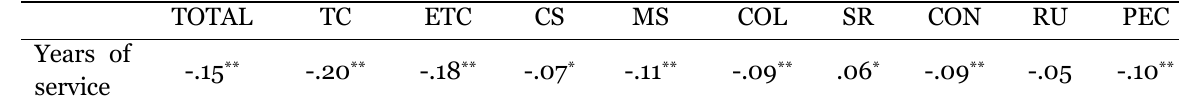
Correlations Between Scores and Years of Service TOTAL TC ETC CS MS